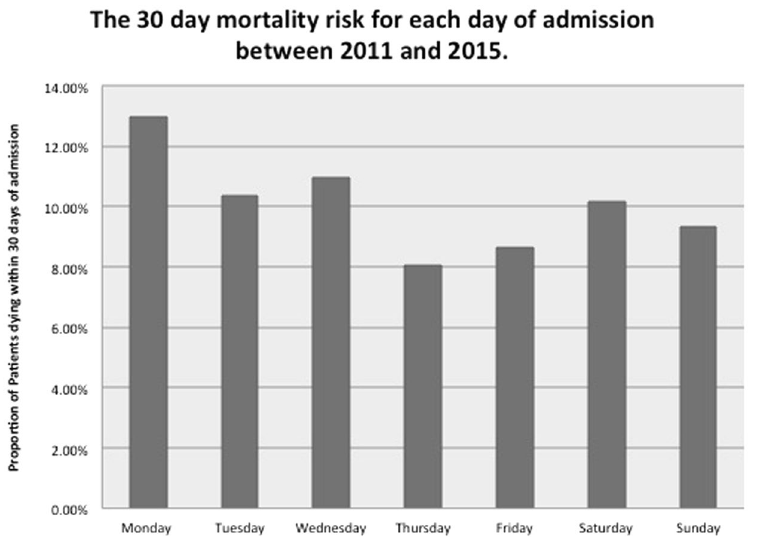
Figure 2. A bar chart illustrating patient mortality risk varied by day of admission between 2010 and